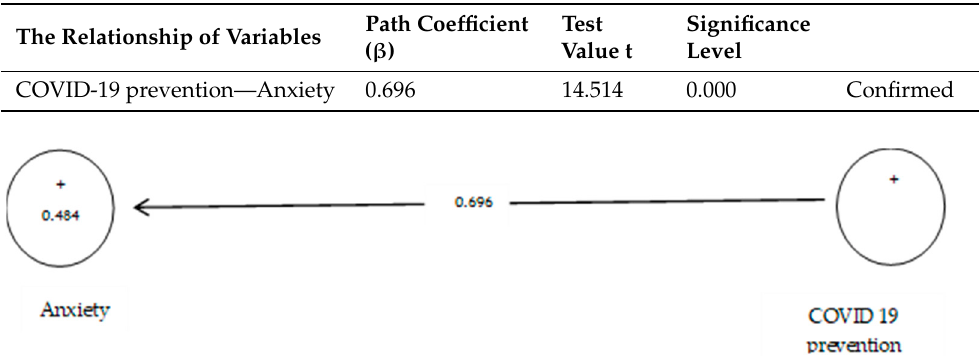
Table 7. Evaluation indicators of the internal model of the research, direction and significance of direct effects.